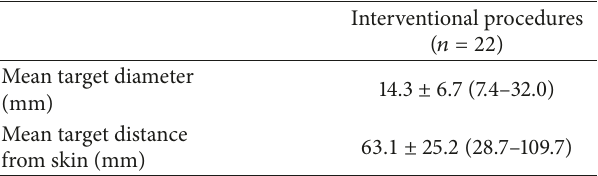
Table 2: Interventional procedure